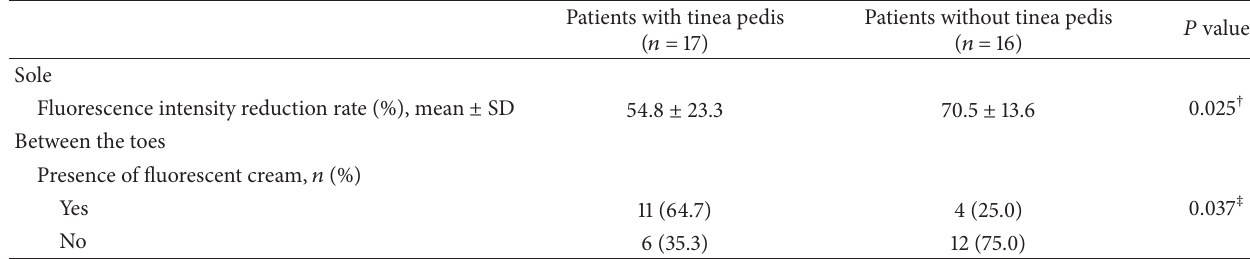
Table 3: Washing residue on the feet. Patients with tinea